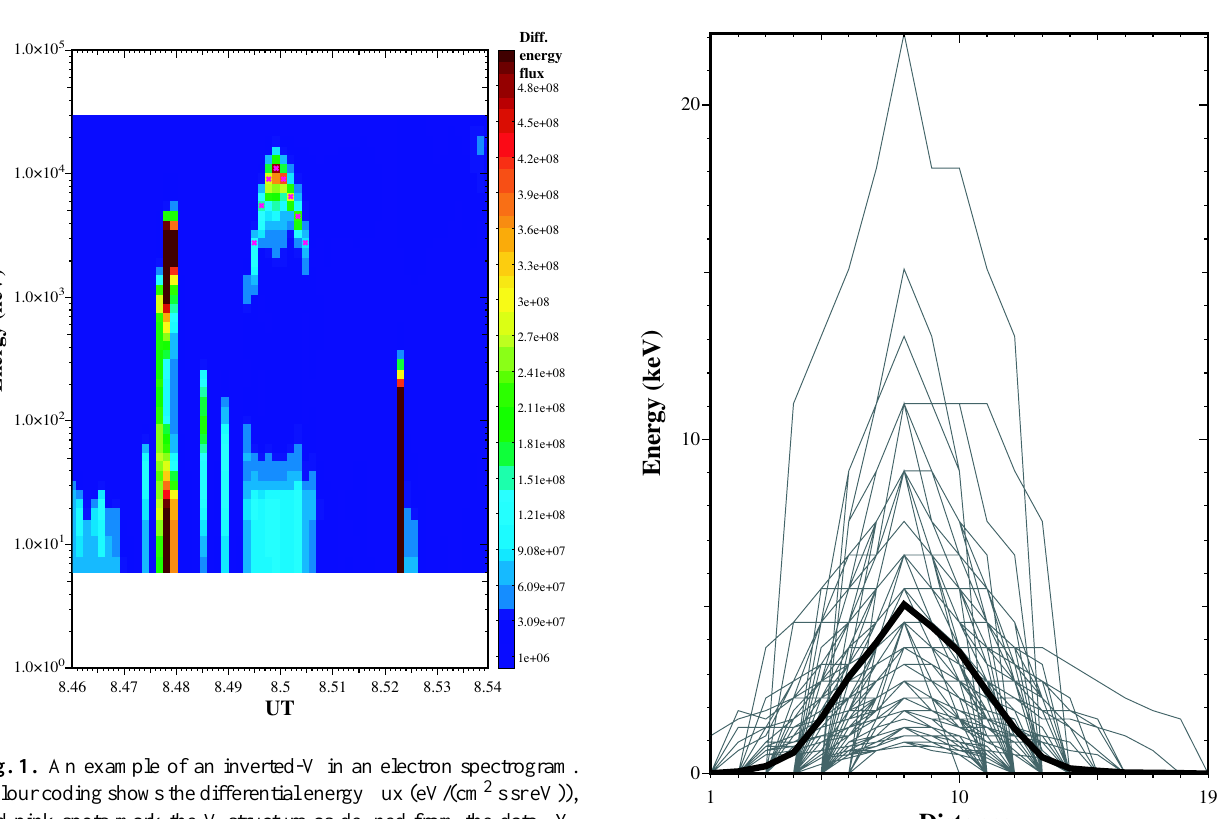
Fig. 1. An example of an inverted-V in an electron spectrogram. Colour coding shows the differential energy flux (eV/(cm 2 s sr eV)), and pink spots mark the V structure as defined from the data. Y- axis is energy and X-axis can be given in latitude (GLAT, ILAT), universal time (UT) or magnetic local time (MLT). This event was observed on 7 May 1999 on the orbit number 10713 at 08:27:36– 08:32:24 UT. FAST saw this inverted-V for about 35 seconds.